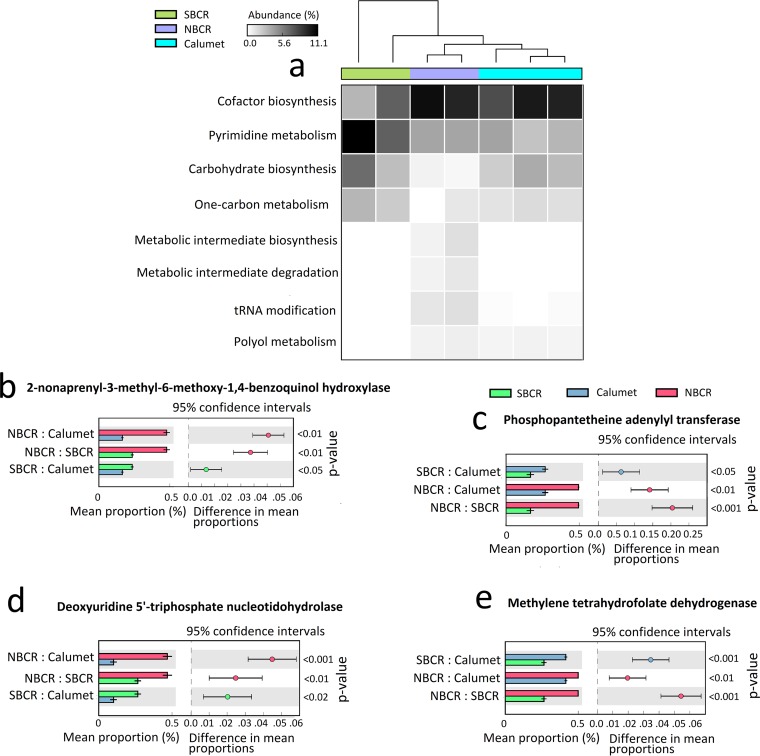
Habitat (WRP)-wide differences in the relative abundance of metabolic pathways and enzymes assembled across Polynucleobacter population bins. (a) ANOVA-based comparative analysis of metabolic pathways enriched across Polynucleobacter population bins. Welch t-test-based comparative analysis of key enzymes involved in cofactor biosynthesis (b and c), pyrimidine metabolism (d), and one-carbon metabolism (e). The FDR was corrected at P < 0.05 (Bonferroni correction).